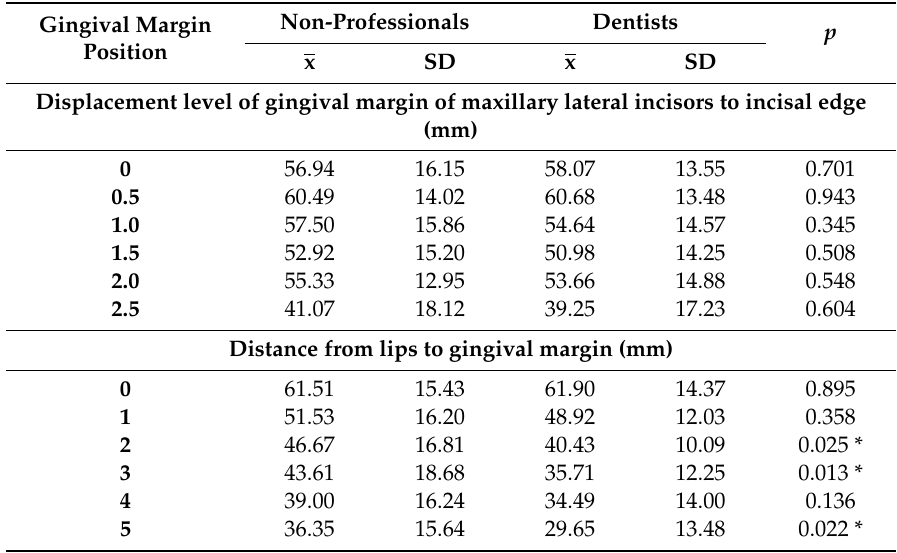
Table 2. Perceptions of dentists and non-professionals towards the gingival margin position. Non-Professionals Dentists Gingival Margin Position SD Displacement level of gingival margin of maxillary lateral incisors to incisal edge